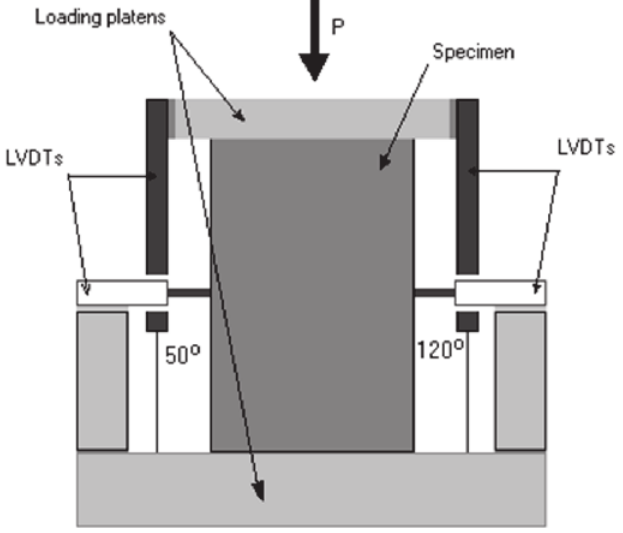
Schematic representation of the position of the loading platens, specimen, LVDTs, and thermal load temperatures